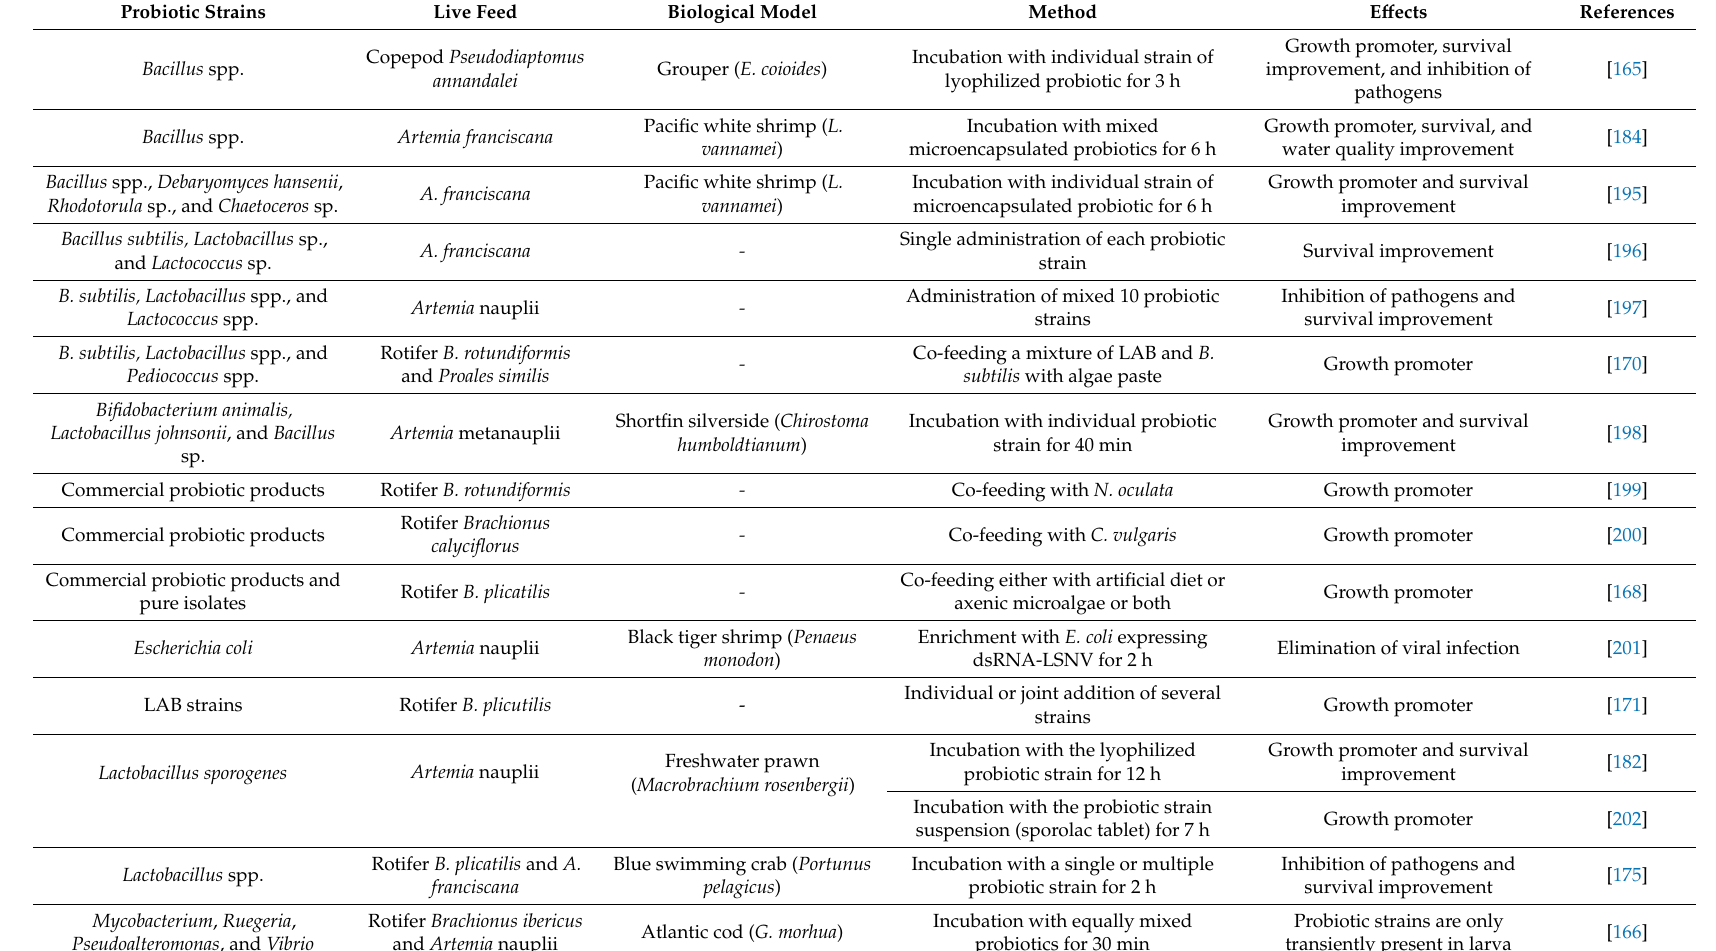
Table 3. Enrichment of live food with